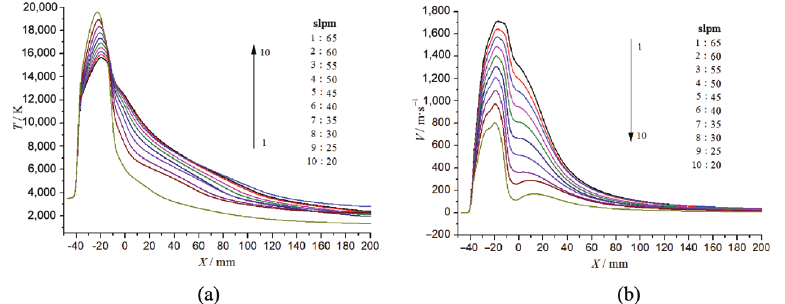
Figure 7: Effect of gas flow rate on plasma jet (a) temperature and (b) velocity distribution along the axial of plasma jet with a constant H 2 /(Ar þ H 2 ) ratio of 20%, carrier gas flow rate of 7 slpm, gas inlet pressure of 0.8 Mpa, electron current of 420 A, power of 65 KW.